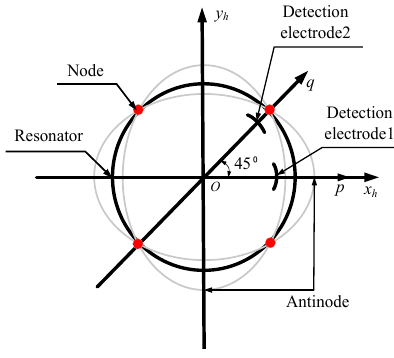
Figure 4. Second-order mode decomposition.